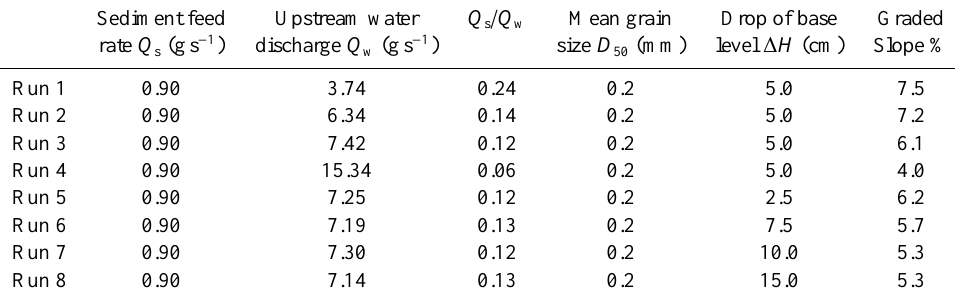
Table 1. List of the experimental conditions. Sediment feed Upstream